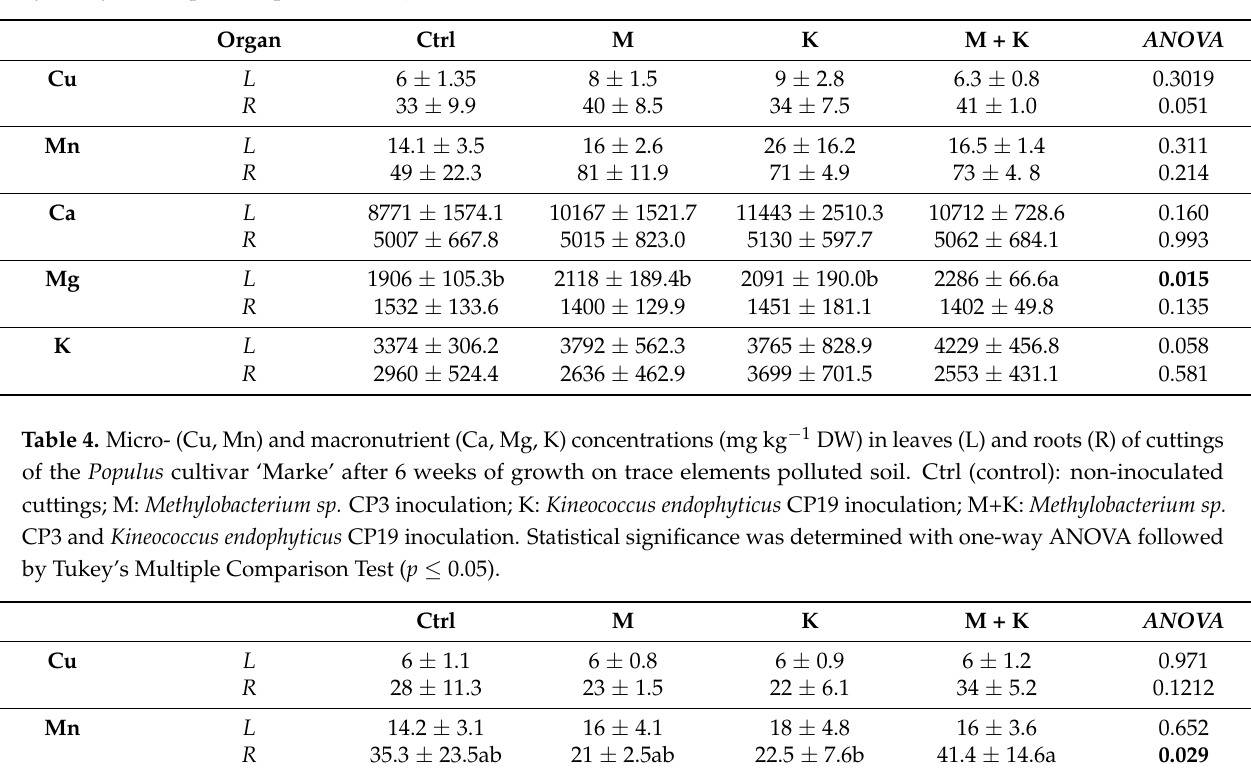
Table 3. Micro- (Cu, Mn) and macronutrient (Ca, Mg, K) concentrations (mg kg − 1 DW) in leaves (L) and roots (R) of cuttings of the Populus cultivar ‘Dender’ after 6 weeks of growth in trace elements polluted soil. Ctrl (control): Non-inoculated cuttings; M: Methylobacterium sp. CP3 inoculation; K: Kineococcus endophyticus CP19 inoculation; M+K: Methylobacterium sp. CP3 and Kineococcus endophyticus CP19 inoculation. Statistical significance was determined with one-way ANOVA followed by Tukey’s Multiple Comparison Test ( p ≤ 0.05).